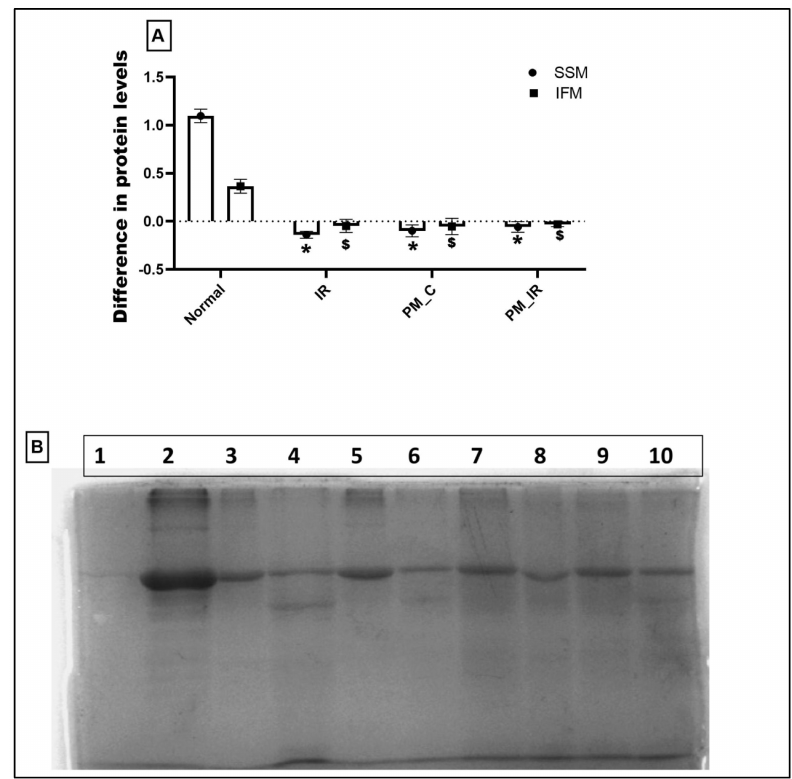
Figure 8. Protein translation ability of mitochondria isolated from the experimental groups. Lanes: 1: Negative control, 2: Positive control, 3–6: IFM fraction of N, IR, PM_C, and PM_IR groups, 7–10: SSM fraction of N, IR, PM_C, and PM_IR groups. ( A ) The difference in protein levels between the different experimental groups. ( B ) Protein translation ability of mitochondria isolated from the experimental groups. Lanes: 1: Negative control, 2: Positive control, 3–6: IFM fraction of N, IR, PM_C, and PM_IR groups, 7–10: SSM fraction of N, IR, PM_C, and PM_IR groups. (* p < 0.05 vs. normal of SSM, $ p < 0.05 vs. normal of IFM) (Supplementary